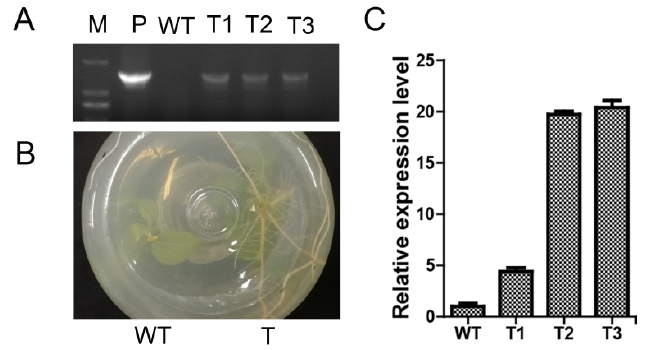
Figure 6. Identification of positive transgenic poplar lines. WT, wild type; T1–3, transgenic poplar lines overexpressing PagERF072 . ( A ) PCR validation of transgenic poplar lines at the DNA level; M, 2000 DNA marker; P, positive plasmid. ( B ) Morphological phenotype of transgenic poplar; T, transgenic poplar. ( C ) qRT-PCR validation of transgenic poplar lines.